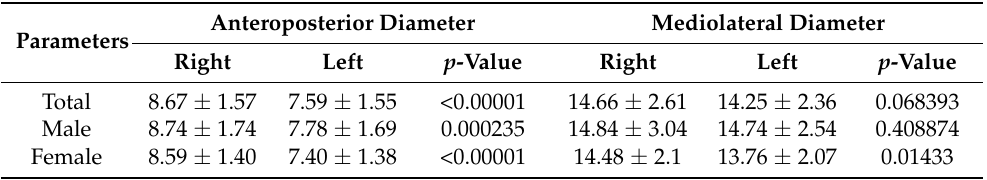
Table 3. Morphometric study of jugular